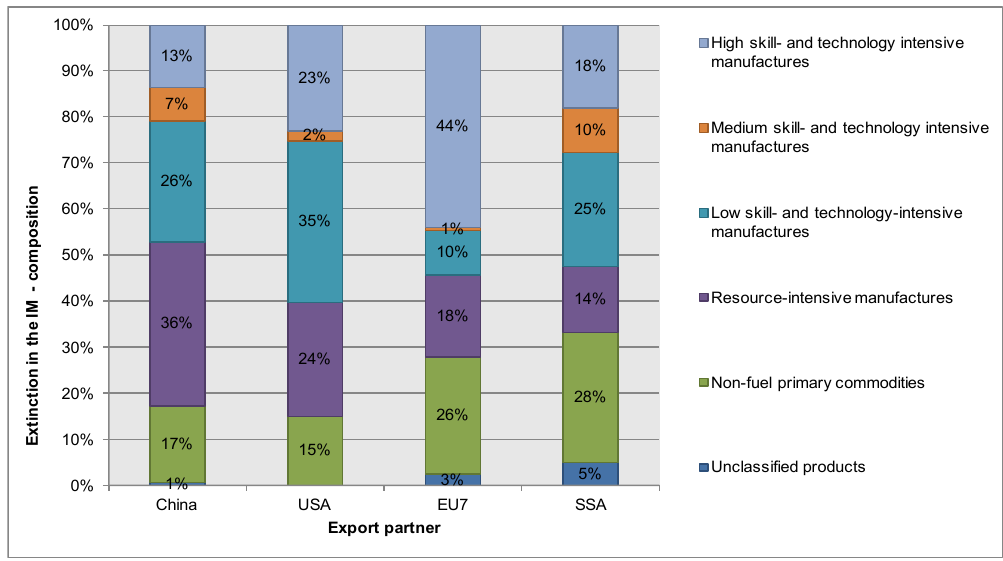
Skills and technology composition of extinctions in South Africa’s intensive margin